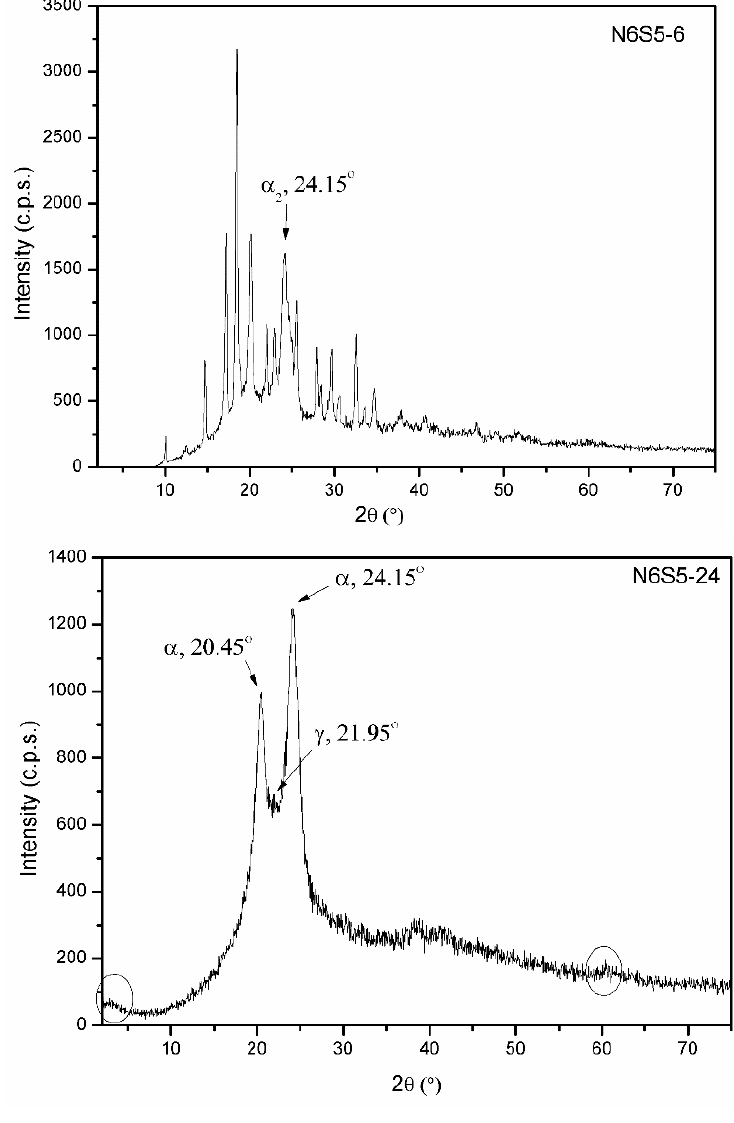
Figure 7. PXRD diagrams of samples N6S5–6 ( top ) and N6S5–24 ( bottom ).